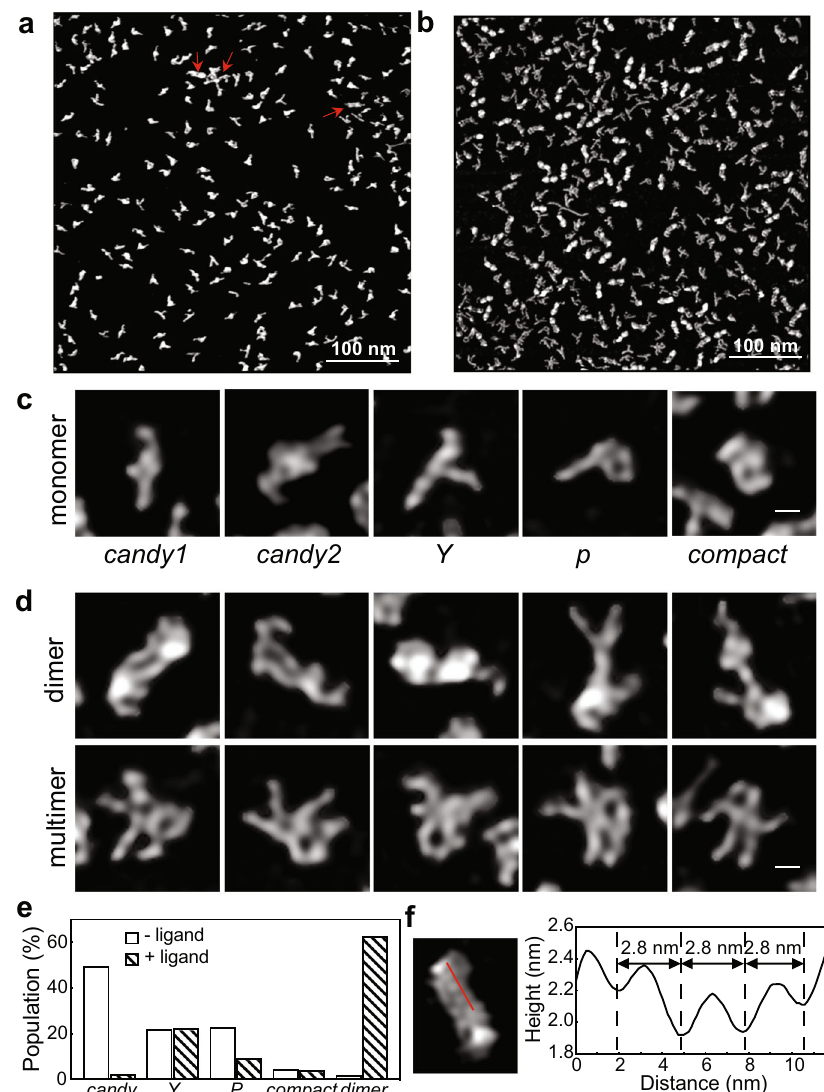
Fig. 1 | Conformational heterogeneity of rCbl in solution. Sections of repre- sentative high-resolution AFM images of rCbl in the absence ( a ) or presence ( b ) of ligand. Red arrows indicate the detection of minor species down to only one or a fewcopiesinsolution.Atotalof12imageswererecordedforrCblintheabsenceof ligand, and 9 images for rCbl in the presence of ligand. c Monomeric conformers. d Dimers are classi fi ed based on shape. The scale bars shown in the right bottom